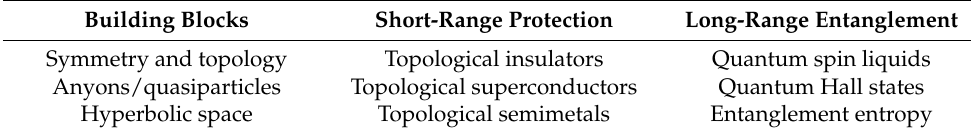
Table 1. Quantum Matter Building Blocks and Short-range and Long-range Matter Phases.